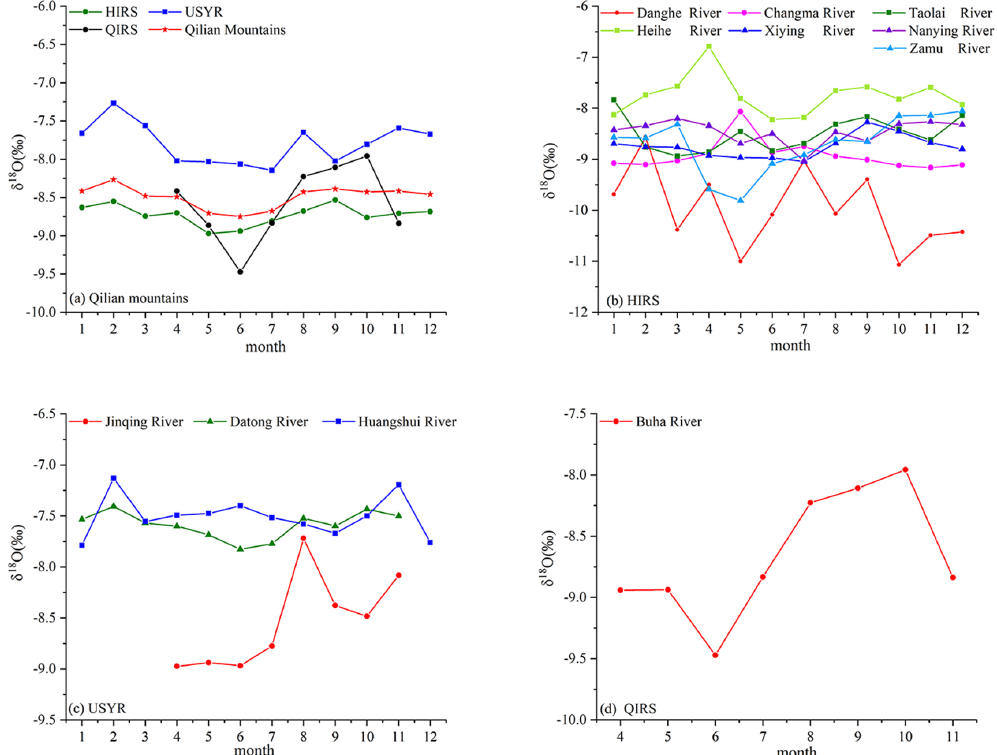
Figure 5. Temporal variation of δ 18 O in the outflow river in the Qilian Mountains.